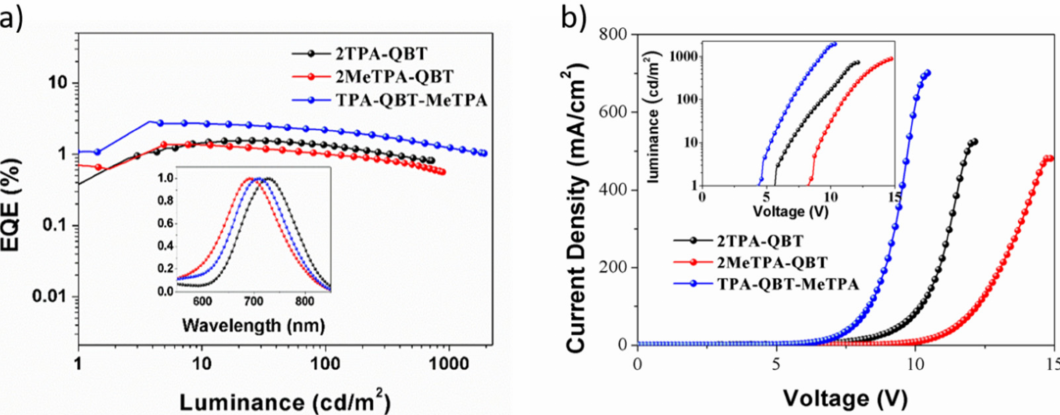
Figure 8. ( a ) External quantum efficiency-luminance curves. Inset: normalized EL spectra of the devices. ( b ) Current density-voltage-luminance